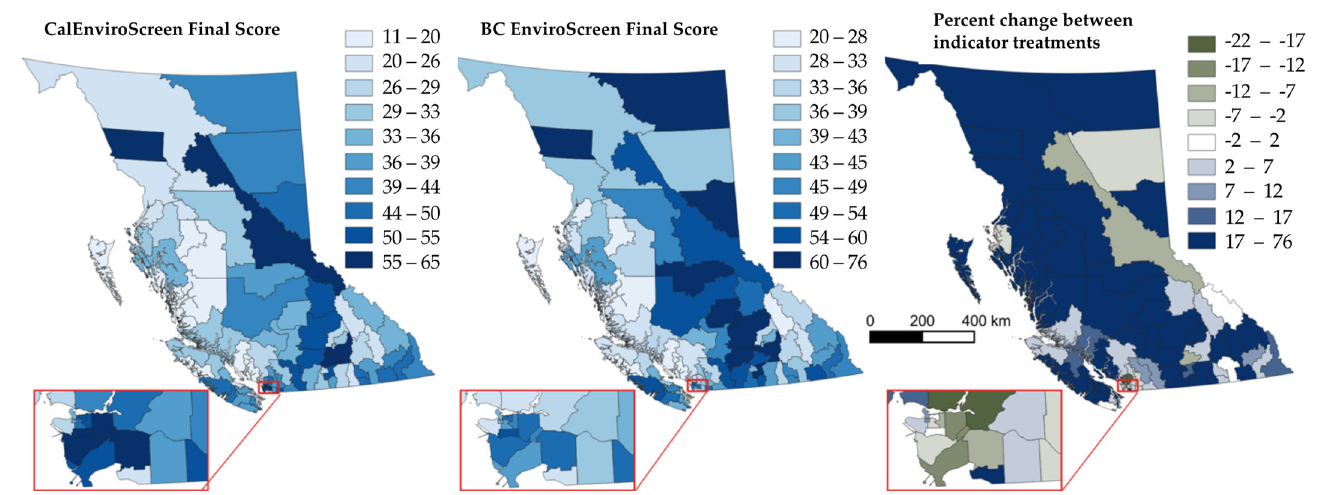
Figure 4. Comparing two treatments of EnviroScreen indicators on overall EnviroScreen scores in British Columbia, Canada.